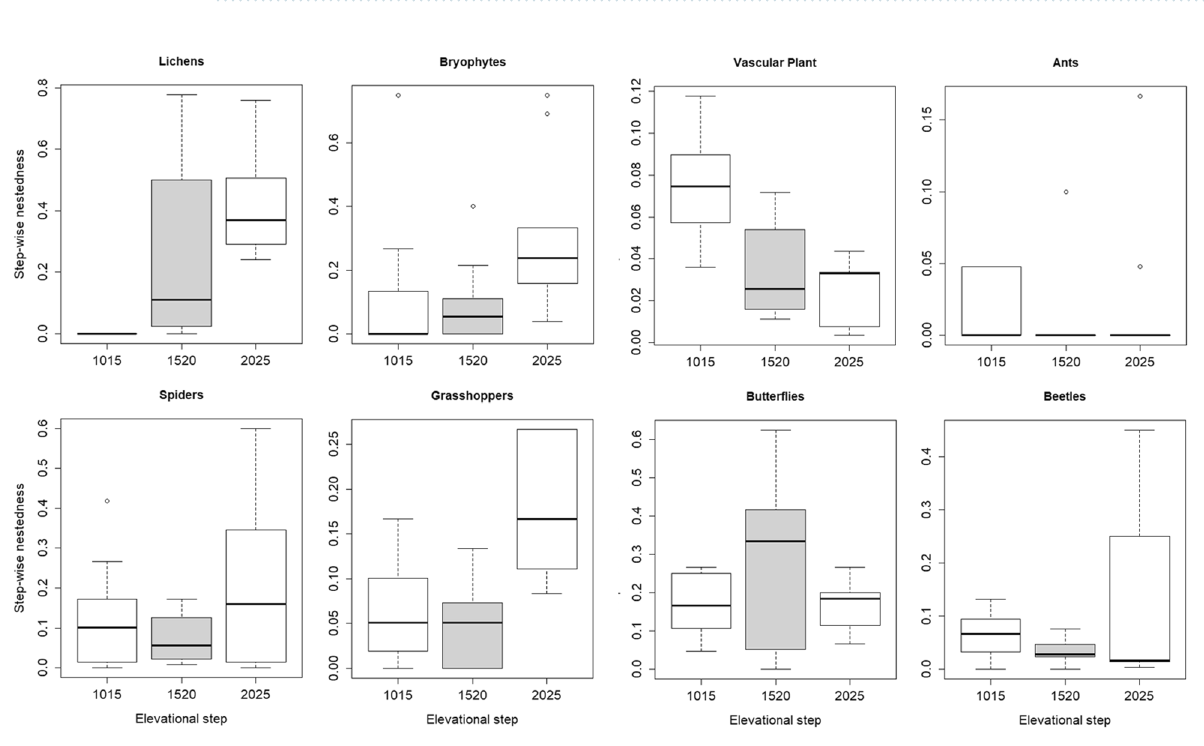
Figure 6. Step-wise nestedness (pair-wise comparisons) of neighboring steps. 1,015… comparison of steps 1,000 and 1,500, 1,520… comparison of steps 1,500 and 2,000, 2,025… comparison of steps 2,000 and 2,500. Figure was produced using R software (version 3.6.2, R Core Team, https ://www.r-proje